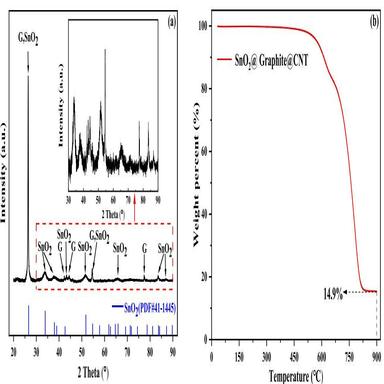
(a) XRD pattern and (b) TGA analysis of the composite.